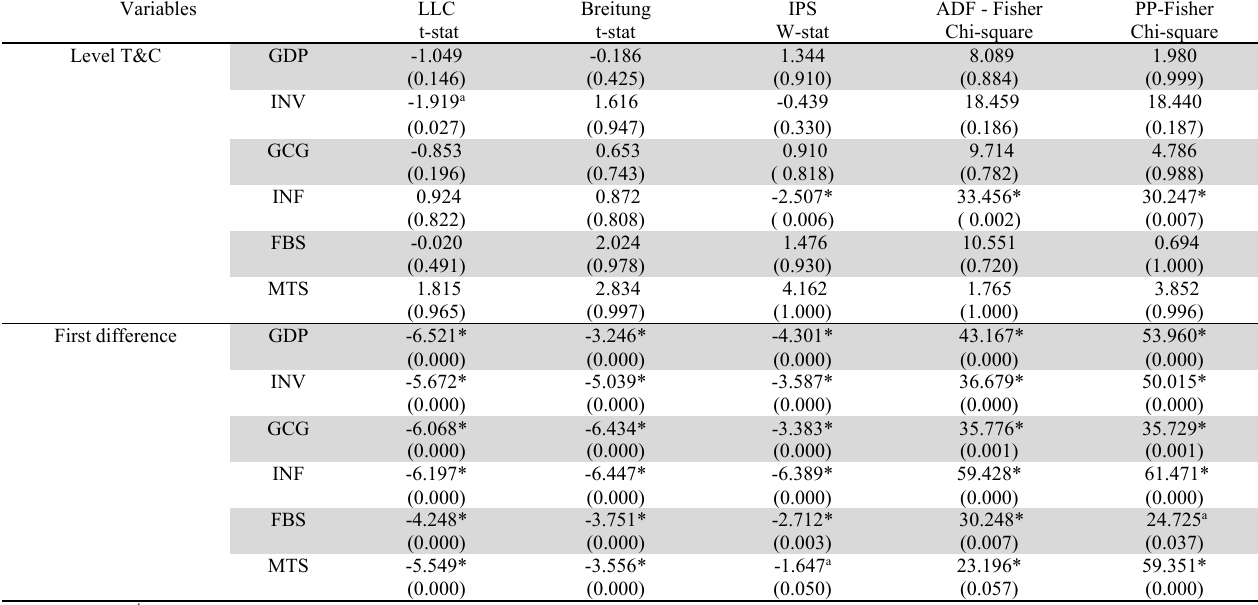
Panel Unit Root